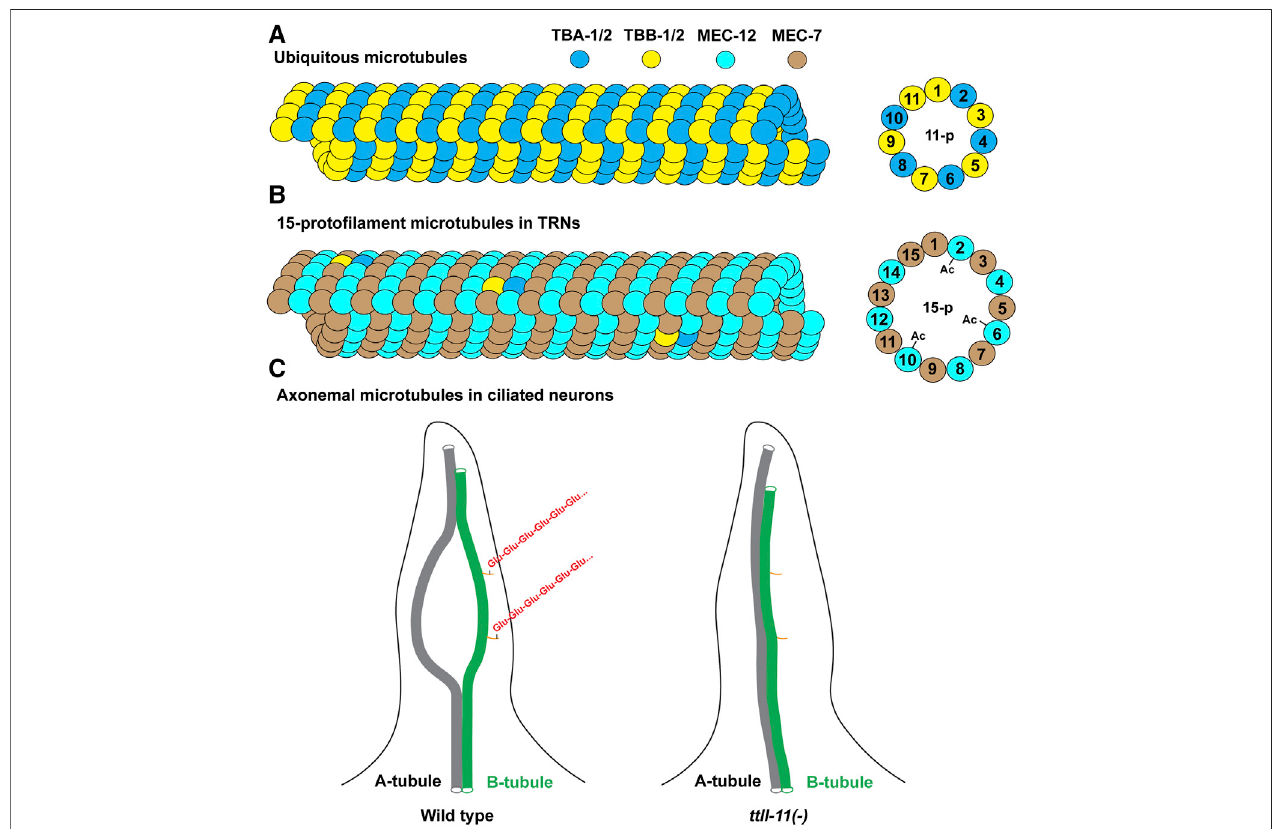
FIGURE5| Illustrationofmicrotubulestructuresin C.elegans . (A) Mostcellsin C.elegans containthe11-proto fi lamentmicrotubulesmademostlyoftheubiquitous tubulin isotypes TBA-1, TBA-2, TBB-1, and TBB-2. Other expressed isotypes can also be incorporated into the microtubules (not depicted). (B) The 15-proto fi lament microtubules in the TRNs are likely made of MEC-12/MEC-7 heterodimers given their high abundance. The lowly expressed TBA-1/2 and TBB-1/2 may also be incorporatedatlowlevels.OnlythemicrotubulesincorporatingMEC-12canbeacetylatedattheK40residues. (C) Thestructureoftheaxonemalmicrotubules(only oneofthenineA-Bdoubletsisdepicted). TheA-BdoubletsplayintoA-tubuleand B-tubulesingletsinthemiddle segmentofthecilia.Polyglutmaylation (achainof “ Glu ” in red) occurs mostly on the C-terminal tail of the tubulins in the B-tubule. A-B doublet fails to splay into singlets in ttll-11(-) mutants. The orange sticks represent the C-terminal tails of the tubulins on B-tubule. Not all tubulin C-terminal tails on the microtubules are depicted.